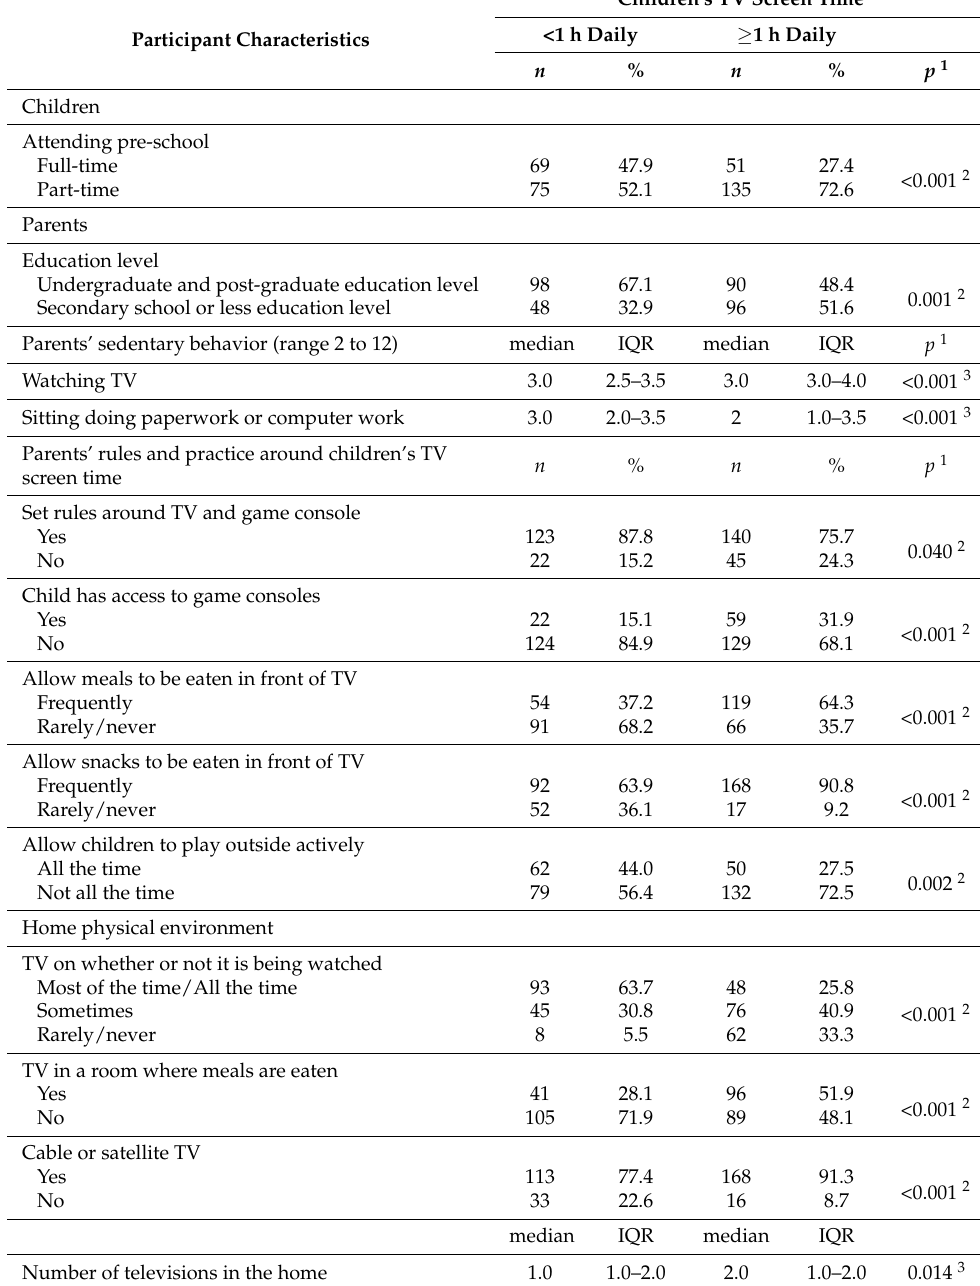
Table 3. Participant characteristics and home environmental characteristics (parents’ rules and practice and home physical environment) associated with children’s TV screen time after bivari- ate